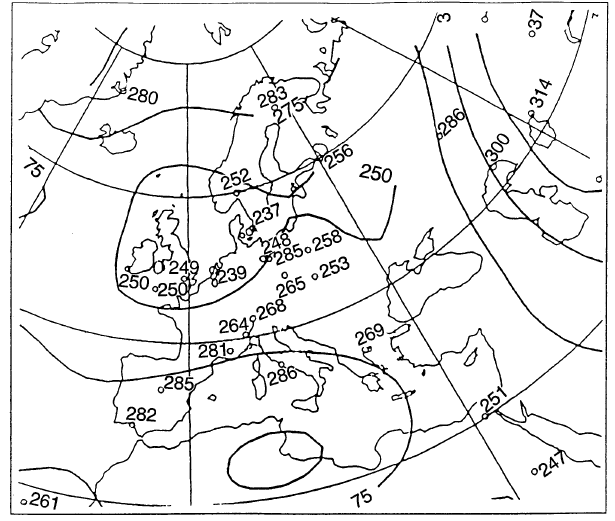
Fig. 9. 5 December 1993: ozone map (Courtesy of LAP Univ. of Thessaloniky,